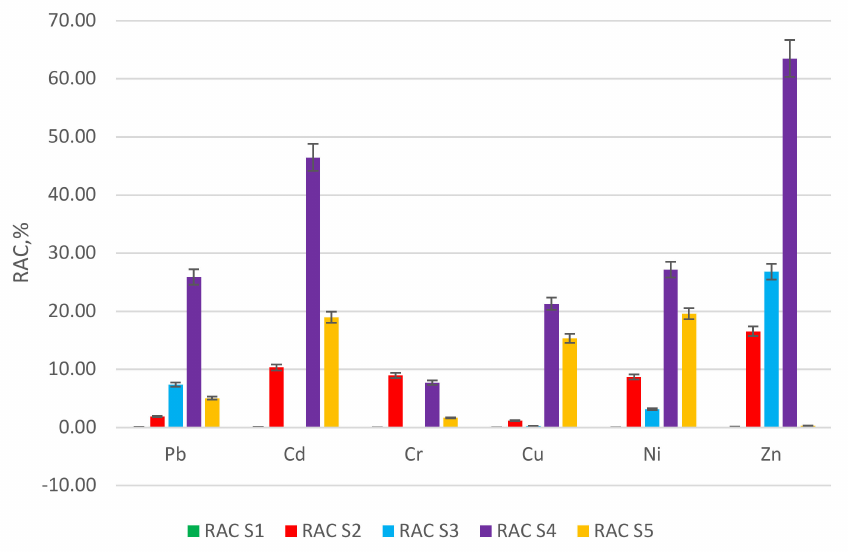
Figure 3. RAC of HMs in SS.